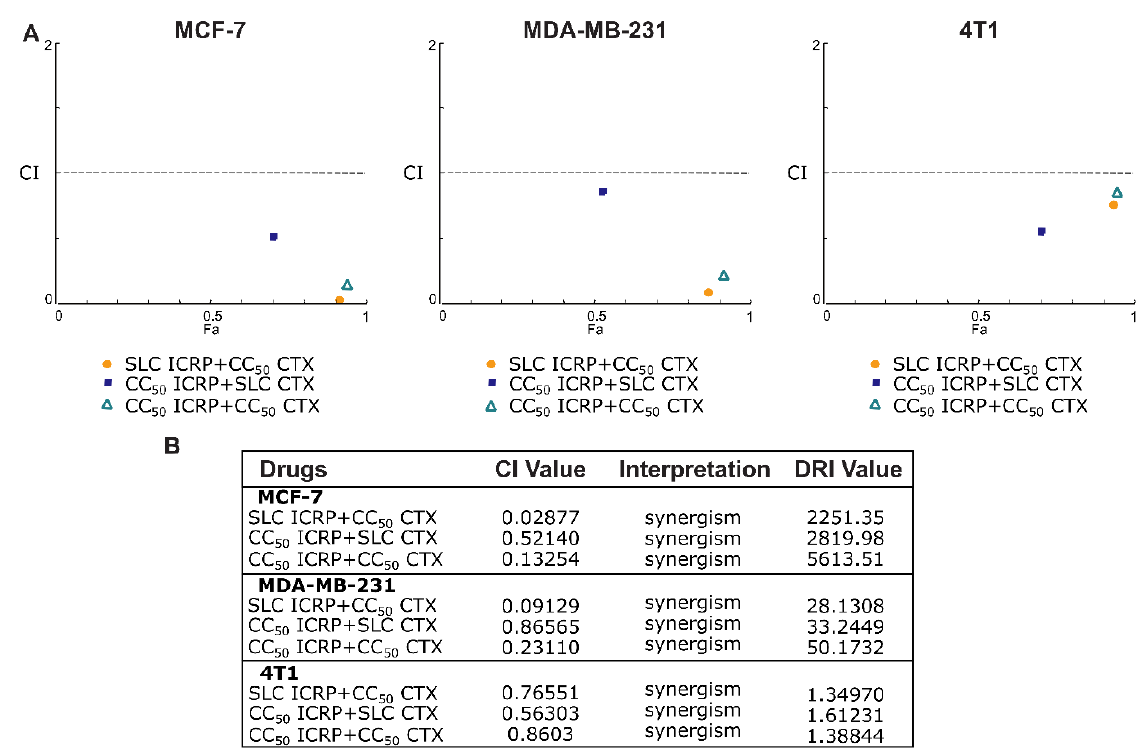
Figure 3: ICRP+CTX induces different cytotoxic effects in breast cancer cells. MCF-7, MDA-MB- 231 and 4T1 were treated with the combination of ICRP+CTX in different ratios for 24 h and cell death was analyzed using the software Compusyn. A ) Fa-CI graphs from cell death. B ) table with the effect of combined ICRP and CTX treatment. CI<1 indicates synergism, additive effect is CI=1, and CI>1 repre- sents